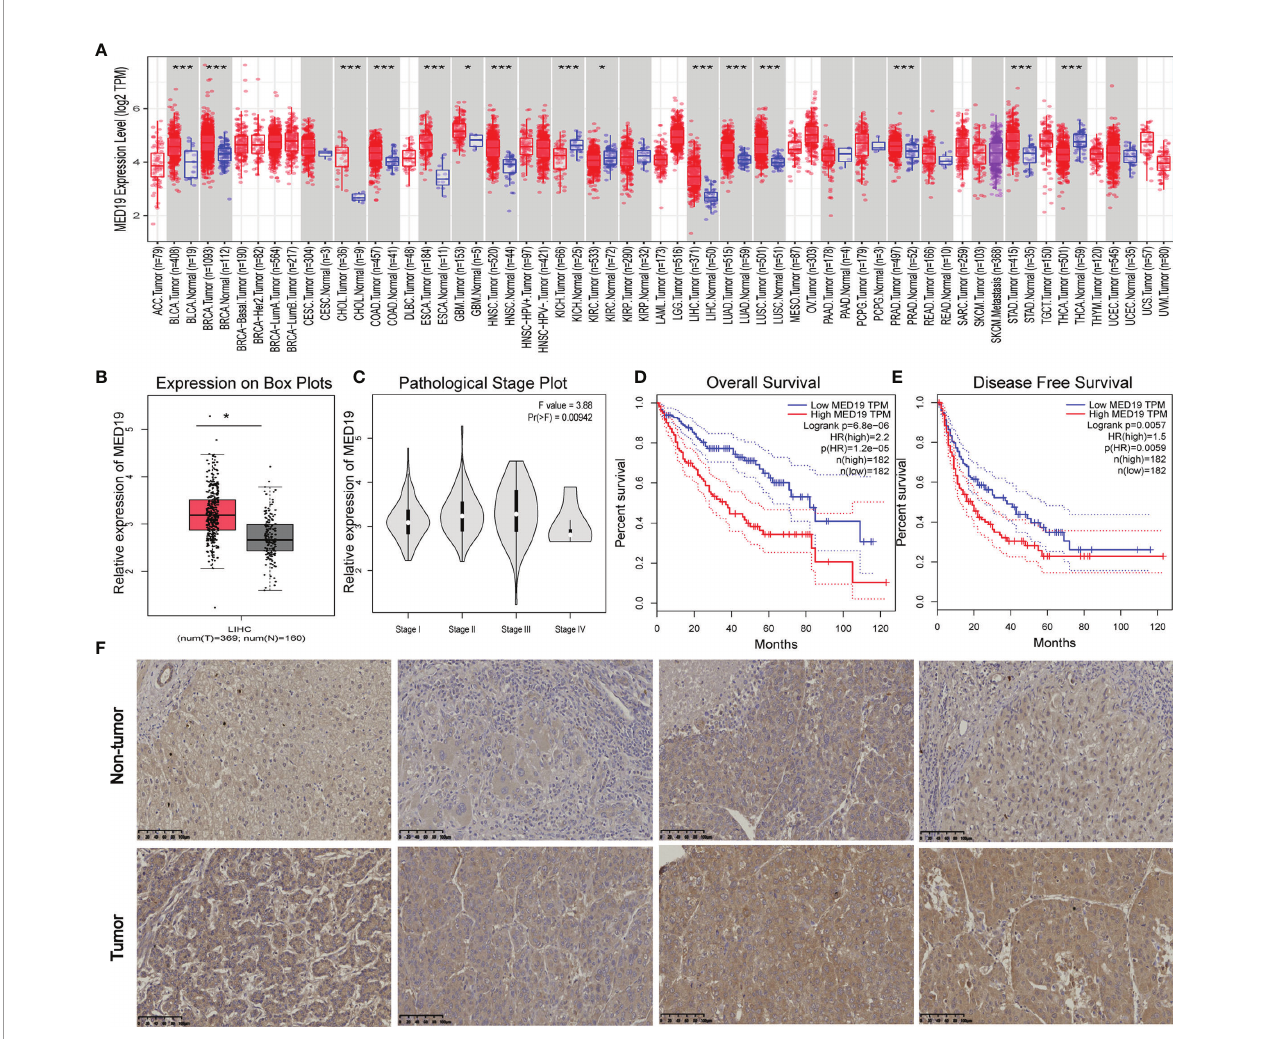
FIGURE 1 | MED19 is highly expressed in HCC. (A) Expression of MED19 gene in different cancers or speci fi c cancer subtypes. (B) MED19 was upregulated in LIHC samples compared with normal tissues. (C) Based on the TCGA data, the expression of the MED19 at different pathological stages of LIHC. (D, E) The higher expression of MED19 was associated with a shorter overall survival time and disease-free survival time of HCC. (F) IHC images of HCC tissues showed that the expression of MED19 in HCC tissues was higher than that in adjacent non-tumor tissues. * P < 0.05; *** P <